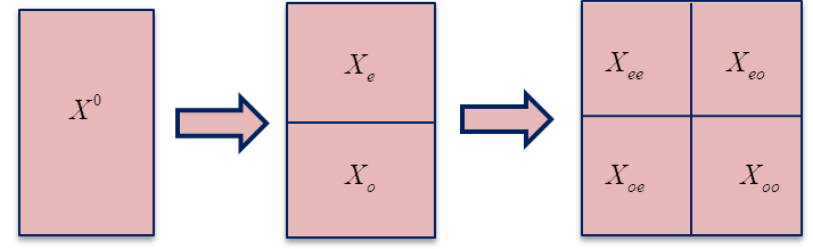
Figure 4. Illustration of hierarchical decompression.